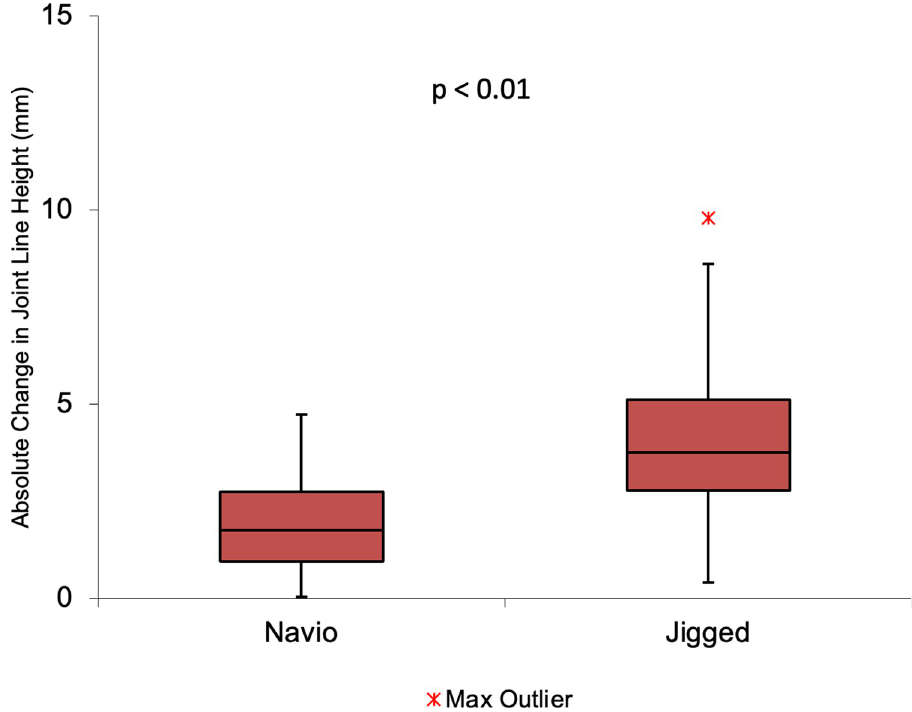
Fig 4. Boxplot for absolute change in joint line height using conventional TKA and Navio TKA.